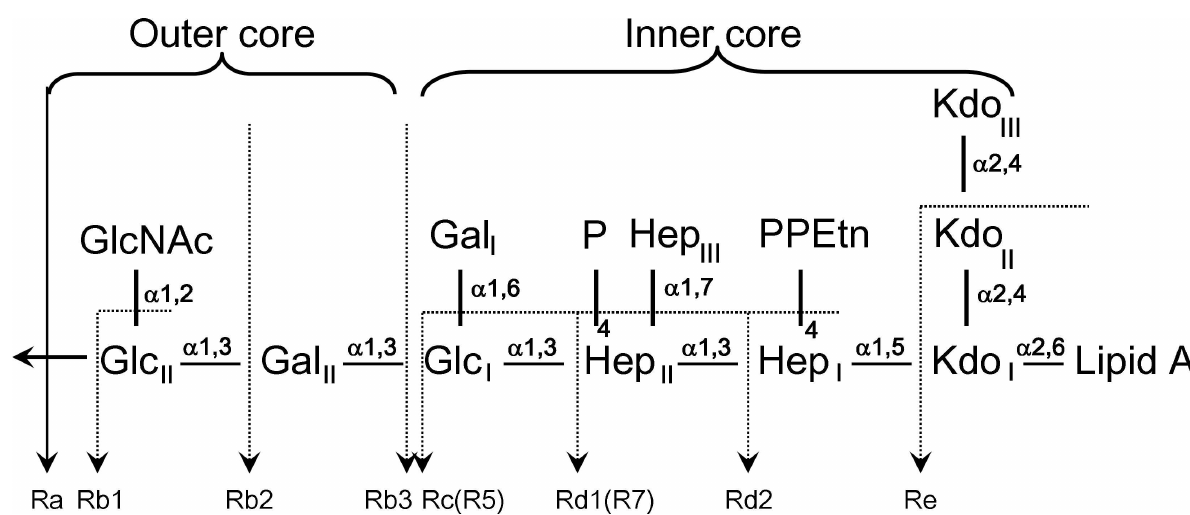
Fig 1. Core LPS structure of Salmonella enterica rough mutant strains. The LPS phenotypes (Ra, Rb1, Rb2, Rb3, Rc, Rd1, Rd2, and Re) and the mutant strains R5 and R7 are shown (modified from Mansfield and Forsythe, 2001 [29]). Glc: glucose; GlcNAc: N-acetyl-glucosamine; Gal: galactose; Hep: L-D-Heptose; P: phosphate; PEtn: phosphoethanolamine; Kdo: 3-deoxy-D- manno -oct-2-ulosonic acid.